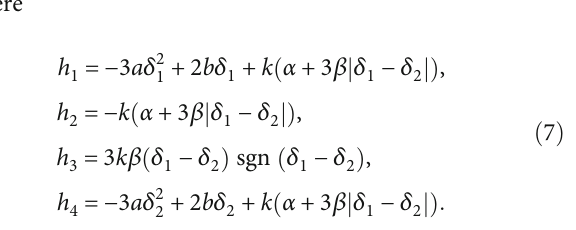
Figure 2: Period-2 fi ring pattern of model (2) when I Phase